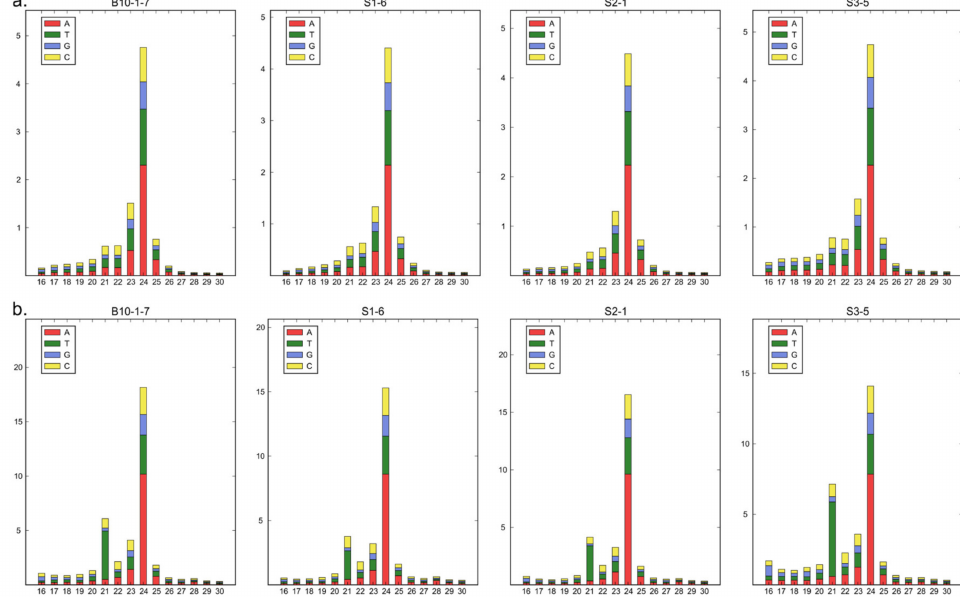
Figure 2. ( a , b ) Length distribution of sRNA sequences of three somaclonal lines (S1, S2 and S3) and control B10 line.